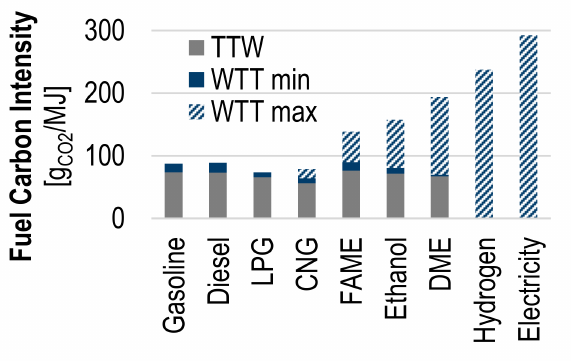
Figure 5. Fuel carbon intensity for selected energy carriers in transportation based on